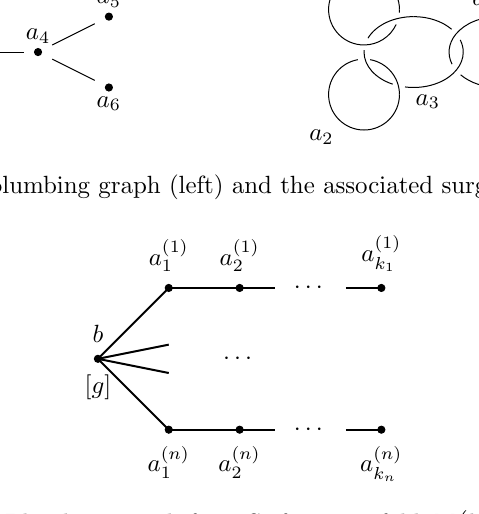
Figure 7 . Plumbing graph for a Seifert manifold M